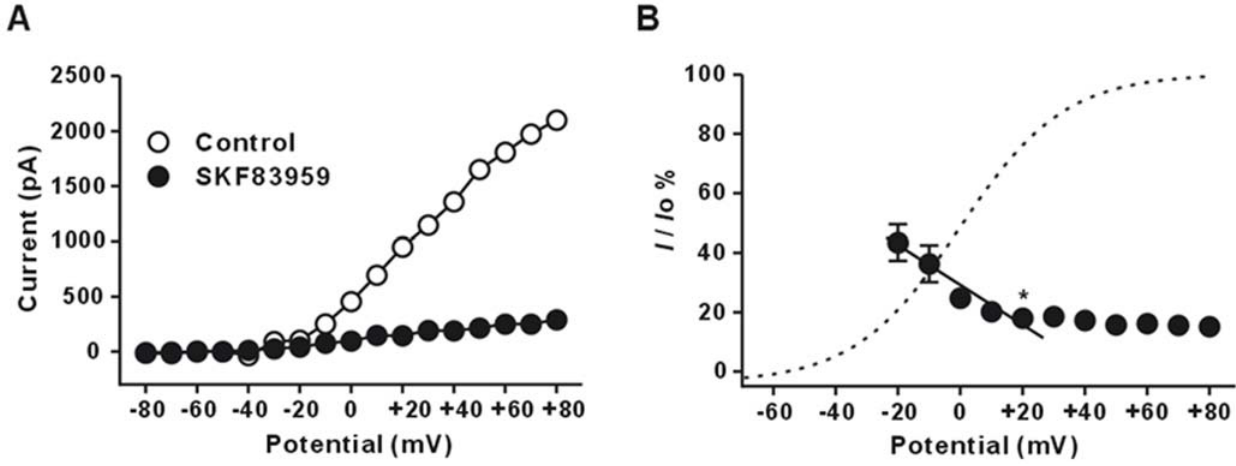
Figure 5. Effects of ( 6 ) SKF83959 on the current-voltage relationships of the delayed rectifier K + current in rat hippocampal neurons. (A) Current-voltage ( I / V ) curves of the delayed rectifier K + current ( I K ) obtained in a representative neuron in control and during superfusion of ( 6 ) SKF83959 (100 m M). (B) Plot of the relative amplitudes of I K during superfusion of ( 6 ) SKF83959 (100 m M) as a function of the test potential. Each symbol represents the mean 6 S.E.M. (n=7). The solid line is the linear fit, while the dashed line is the activation curve obtained in control condition. * P , 0.01 (one-way ANOVA test) versus the value at 2 20 mV.